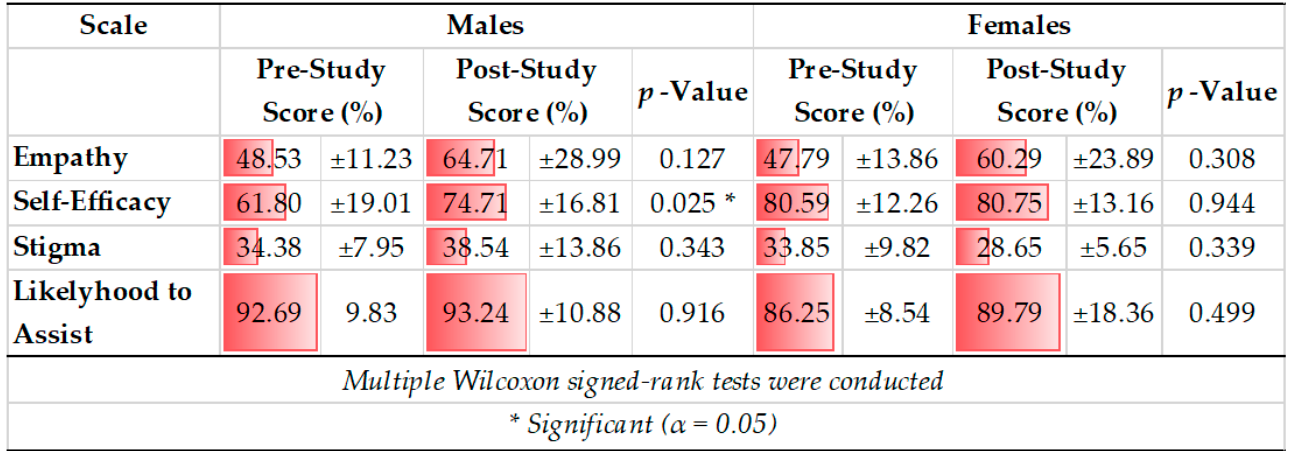
Table 3. Pre- vs. Post-Study Survey Score Comparison for All 4 Scales within Males and Females.